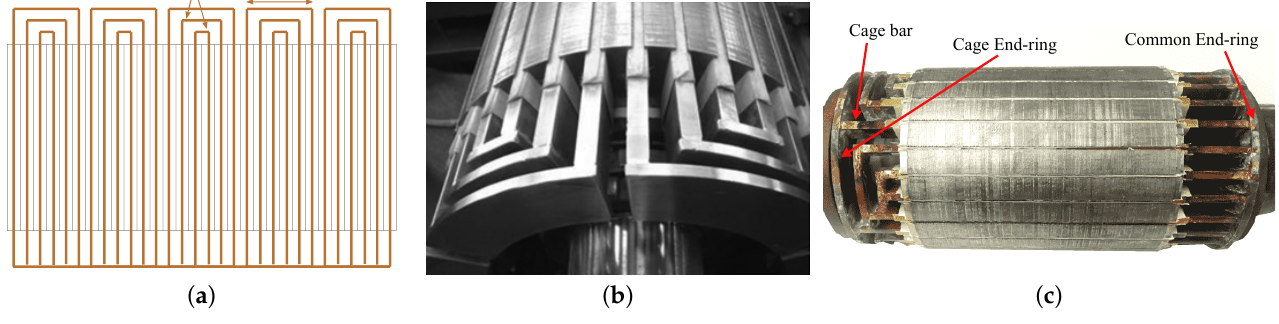
Figure 9. Widely used BDFM rotors: ( a ) NL rotor winding arrangement for p 1 + p 2 = 5, ( b ) NL rotor prototype [42], and ( c ) Cage + NL rotor